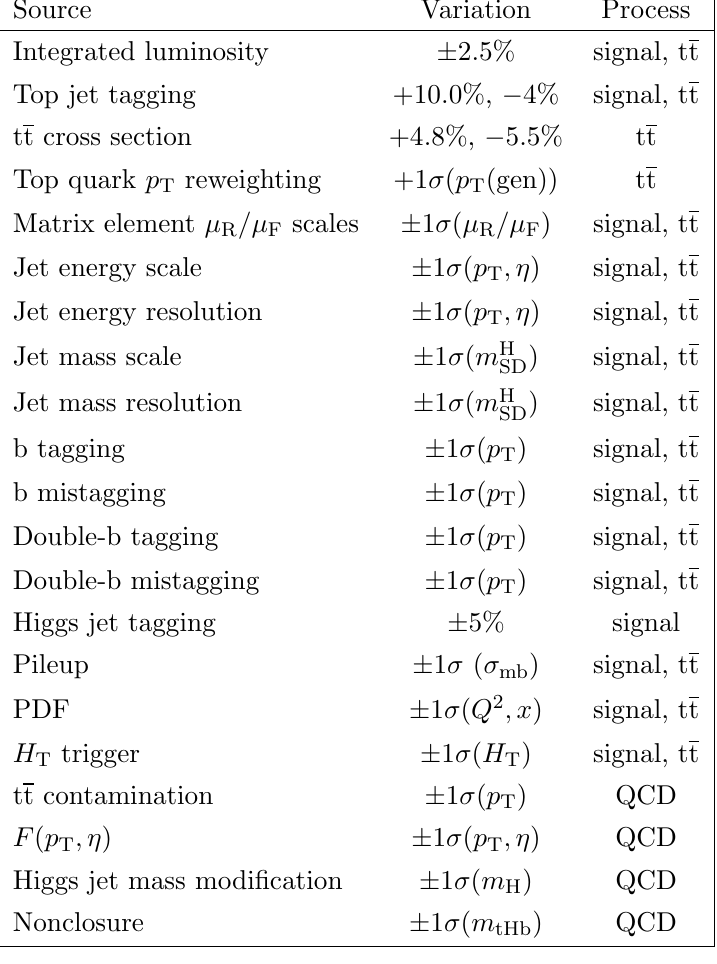
Table 3 . Sources of systematic uncertainty a(cid:11)ecting the m tHb distribution. Sources that list the systematic variation as 1 (cid:27) depend on the distribution of the variable given in the parentheses, (cid:6) while those that list the variation in percent are rate uncertainties.